Question: Condense the content of this figure into a single sentence.
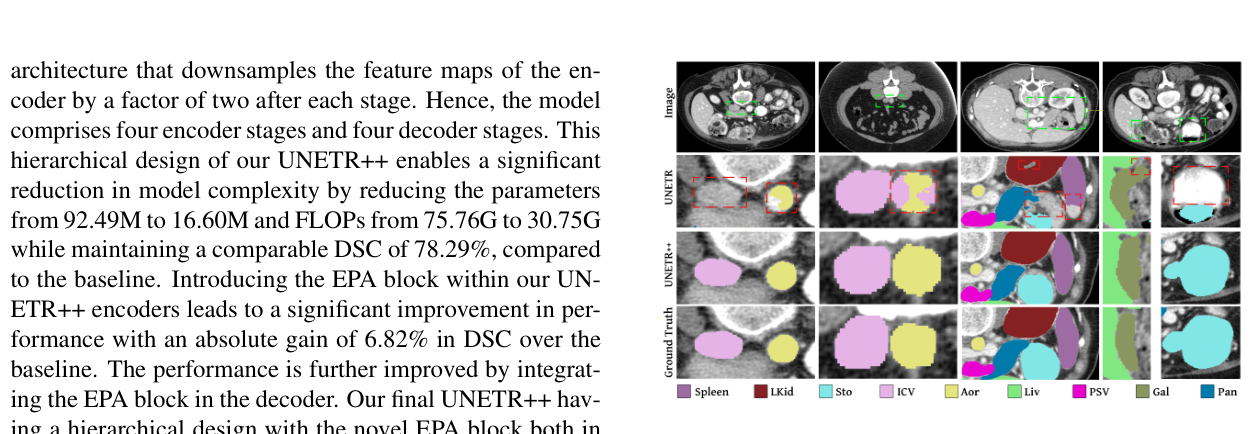
Answer: Qualitative comparison between UNETR++ and base- line UNETR on Synapse. For better visualization, we enlarged different areas (marked in green dashed box) in the images. The inaccurate segmentations are marked by red dashed boxes. Com- pared to the baseline, UNETR++ achieves superior segmentation performance. Best viewed in zoom.